Question: Describe this figure in one sentence.
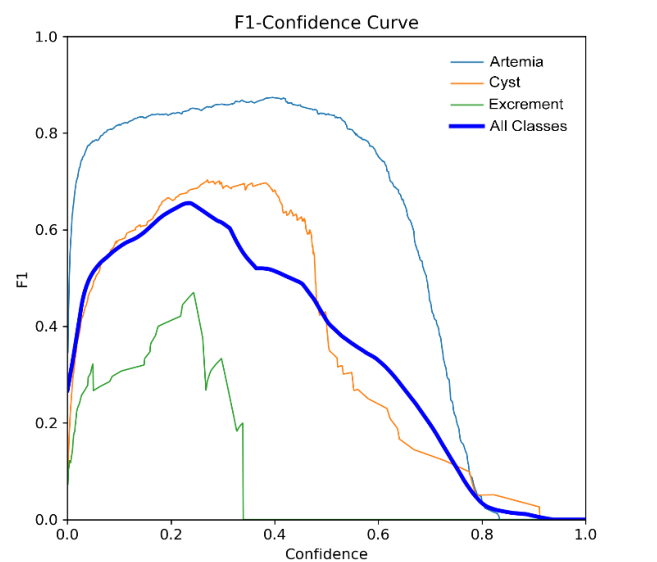
Answer: YOLOv8 F1 - Confidence curve